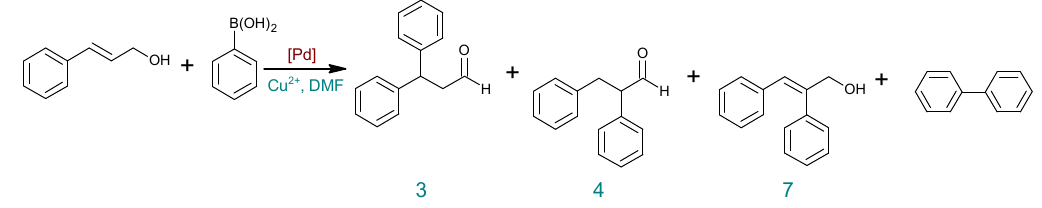
Table 5. Results of the Heck reaction of cinnamyl alcohol with